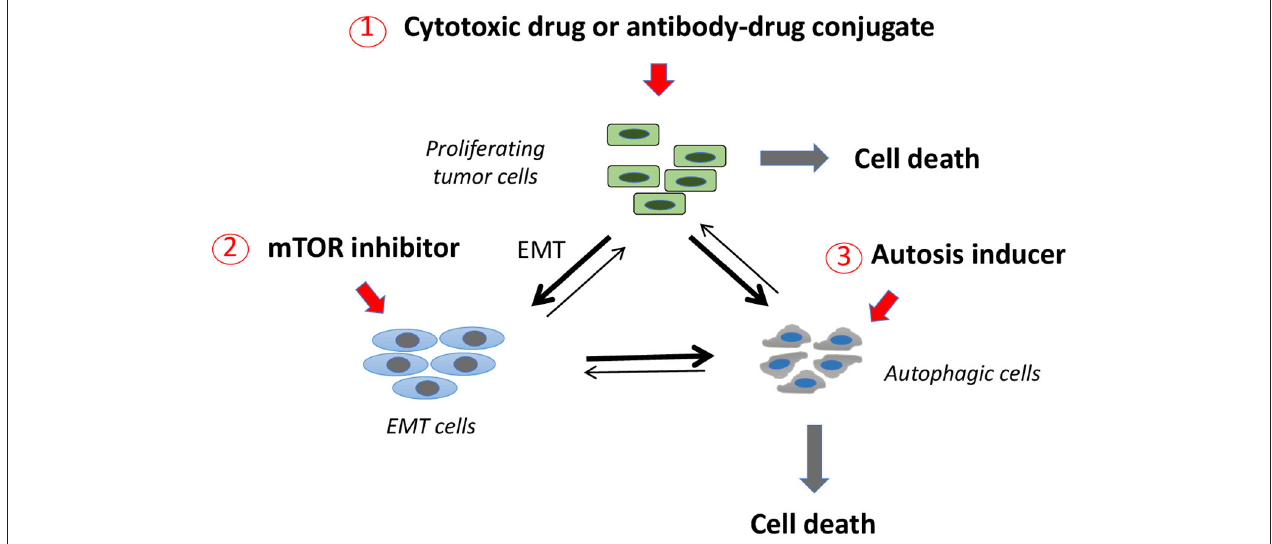
FIGURE 2 | A three-pronged therapeutic approach to target three major tumor cell subpopulations. Proliferating, differentiated tumor cells may be targeted with classical cytotoxic drugs or with antibody-drug conjugates. Tumor cells that come in contact with cytotoxic drug concentrations that are subcytotoxic may respond to this stress by undergoing EMT or autophagy (thick lines). mTOR inhibitors are a second class of drugs that may act preferentially on EMT tumor cells, inducing them to undergo autophagy (thick line). Autophagic cells may be induced toward demise by a third class of drugs, inducers of autophagic cell death (autosis). This therapeutic scheme is expected to act on the three major tumor cell populations leading to their demise and avoiding them to accumulate in one of the two resistant compartments (i.e., EMT or autophagic tumor cells) as a consequence of genotoxic stress.